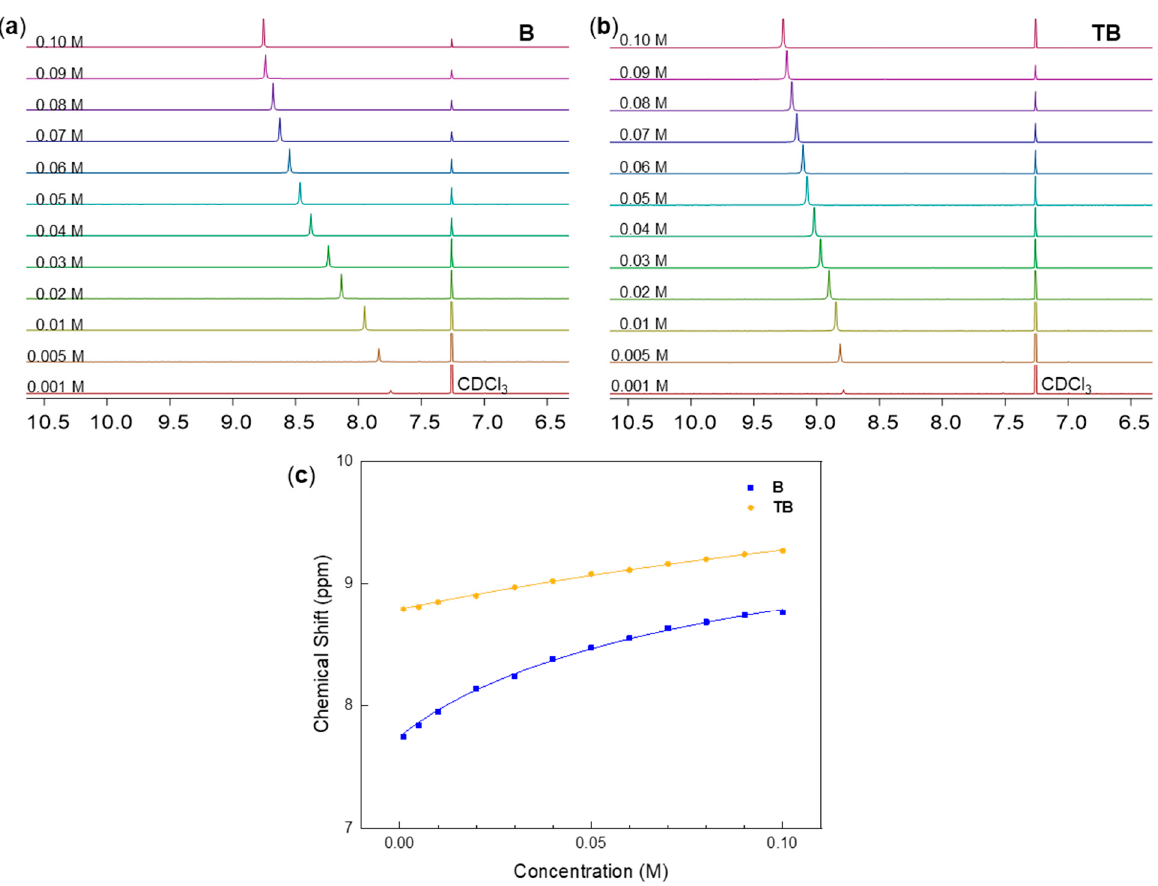
Figure 1. ( a , b ) Concentration-dependent NMR spectra of model compounds B and TB in CDCl 3 measured at 27 °C and ( c ) their fitting curves of the chemical shifts of the N-H (for fitting details, see Supplementary Materials). Table 1. Association constant K assn. , maximum chemical shift of N-H δ max , Gibbs free energy of association ∆𝐺 (cid:3028)(cid:3046)(cid:3046)(cid:3041). , coales- cence rate constant k C , Gibbs free energy of coalescence ∆𝐺 (cid:3030)(cid:2999) , and exchange equilibrium constant K − 15°C of model com- pounds B and TB .